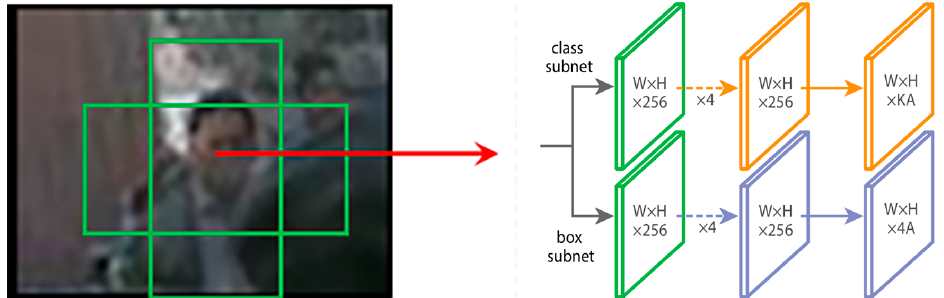
Figure 10. Results of classification to false negative. (RetinaNet)